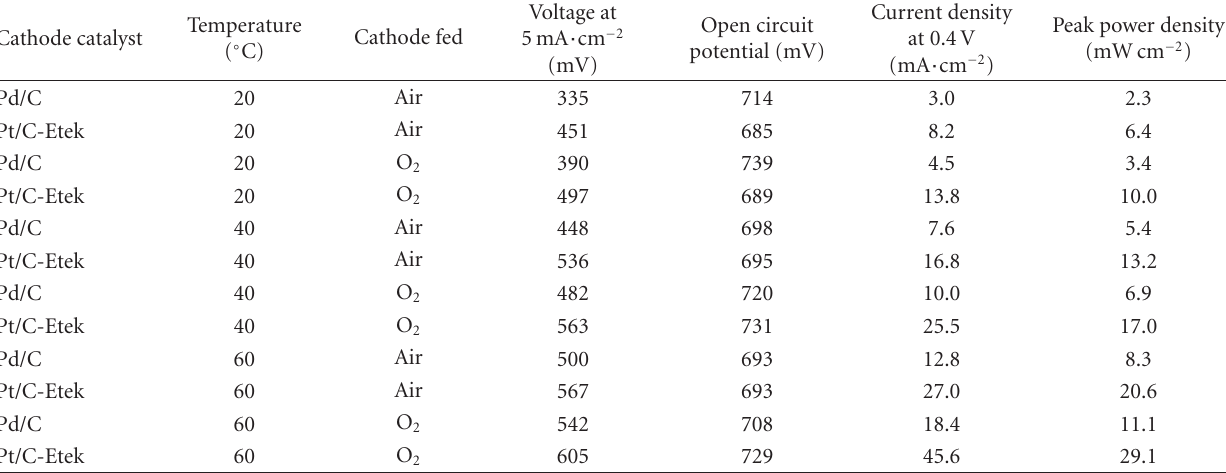
Figure 11: (a) Anode polarization curves for a fuel cell with PtRu/C from E-tek anode catalyst and Pd/C cathode catalyst at 20, 40, and 60 ◦ C fed with methanol 5 M. (b) Cathode polarization curves for Pt MEA for a DMFC at 20, 40, and 60 ◦ C fed with 5M methanol solution compared to data from a H 2 PEM fuel cell. (c) Cathode polarization curves for Pd MEA for a DMFC at 20, 40, and 60 ◦ C fed with 5M methanol solution compared to data from a H 2 PEM fuel cell. Table 2: Current densities at 0.4V, cell voltage at 5mA · cm − 2 , open circuit potential and peak power densities for a direct methanol fuel cell with 1M